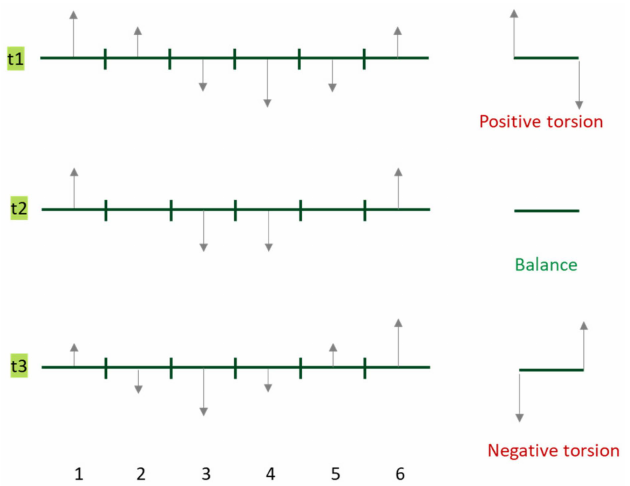
Figure 12. 48th order tangential electromagnetic force distribution of a ‘liner’ shape